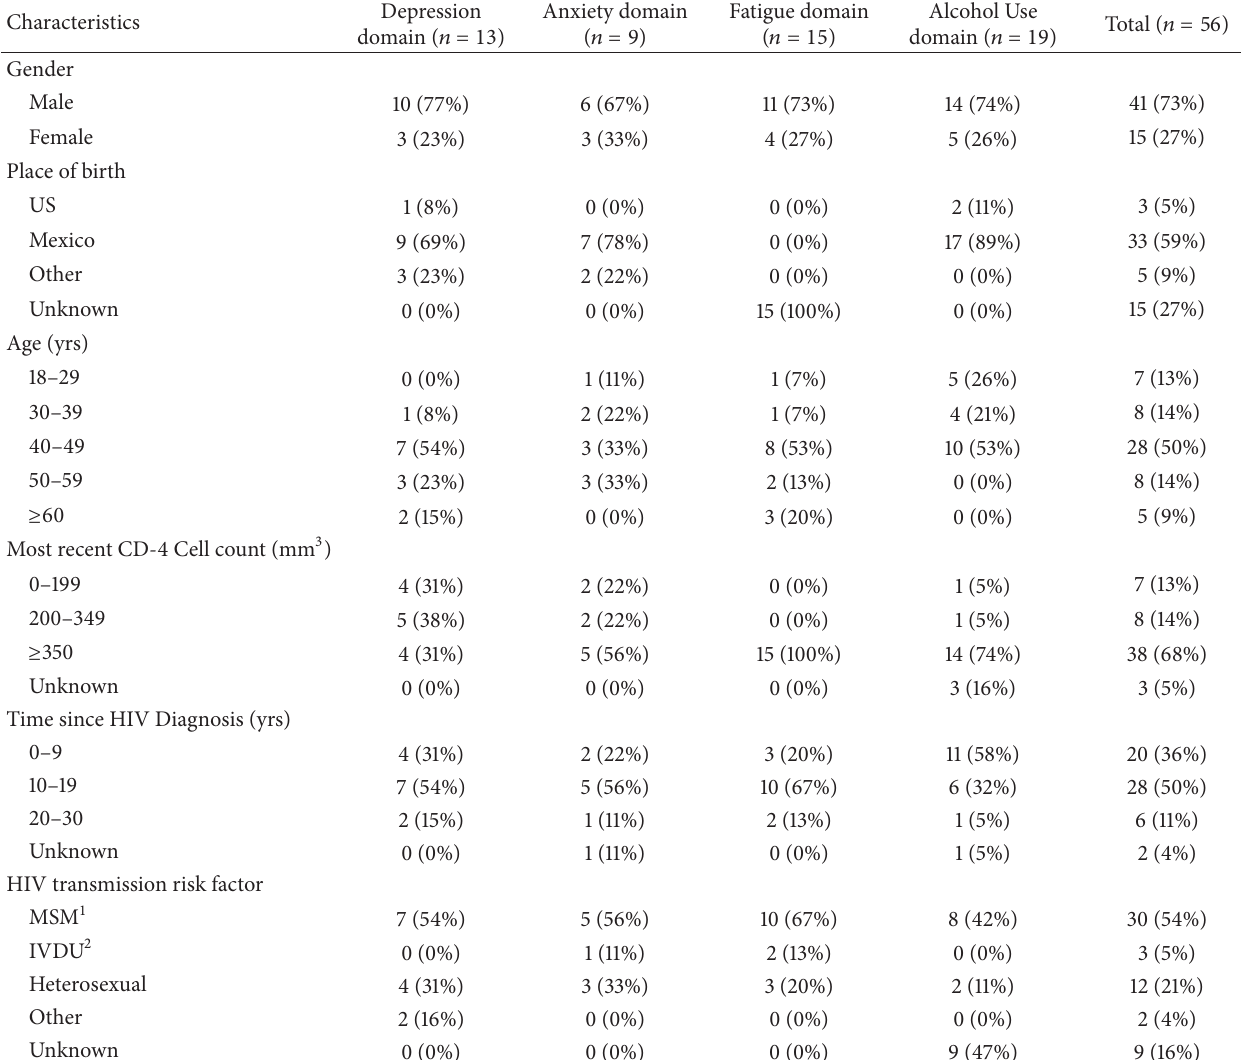
Table 1: Characteristics of the participant population for the first round of cognitive